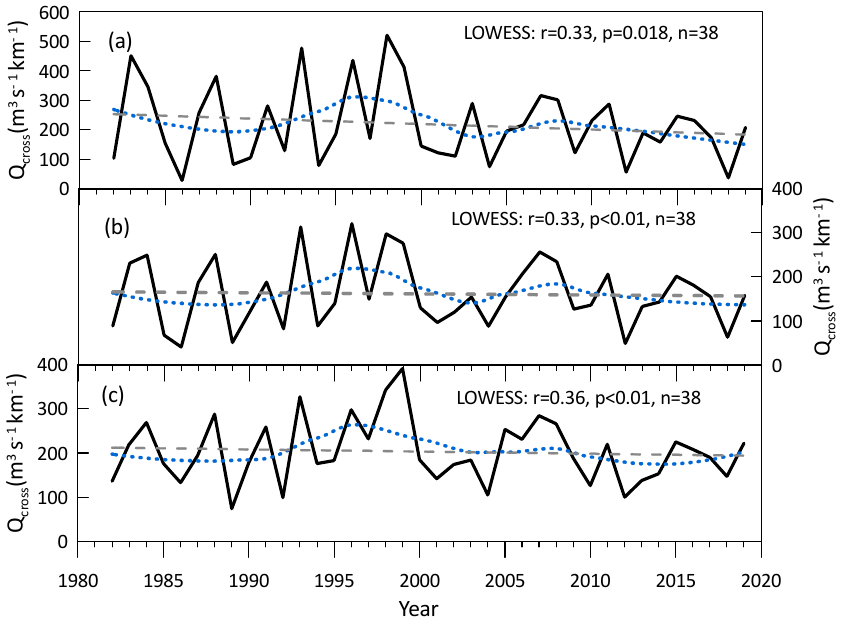
Figure 5. Temporal variation of cross − shore Ekman transport (Q cross ) from 1982 to 2019 for PTU ( a ), DSU ( b ), and TBU ( c ). The blue dotted lines and grey dashed liens represent the LOWESS fit lines and linear fit lines, respectively.